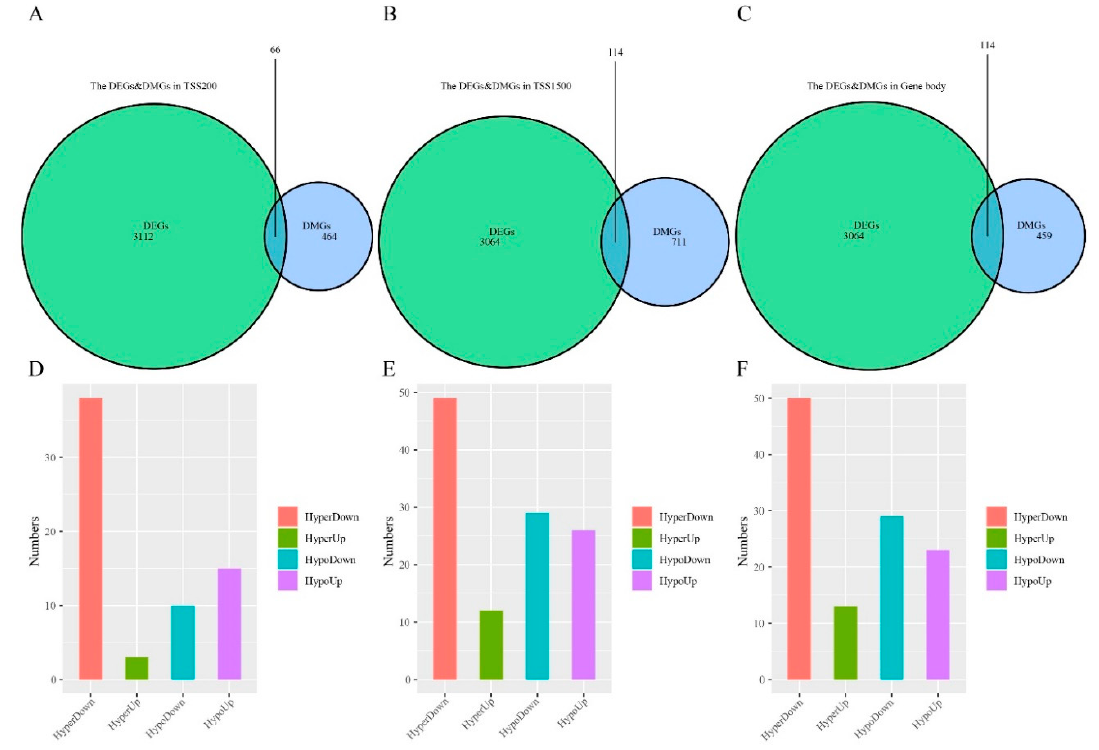
Figure 4. Differentially methylated and expressed genes (DMEGs) in “EGFR Wild Type/Low PD-L1 expression” NSCLC. ( A – C ) Venn map showing the DMEGs between DMGs and DEGs in TSS200, TSS1500, and gene body regions. ( D – F ) Histogram showing the number of four regulation patterns between methylation and expression of “EGFR Wild Type/Low PD-L1 expression” NSCLC in three regions.